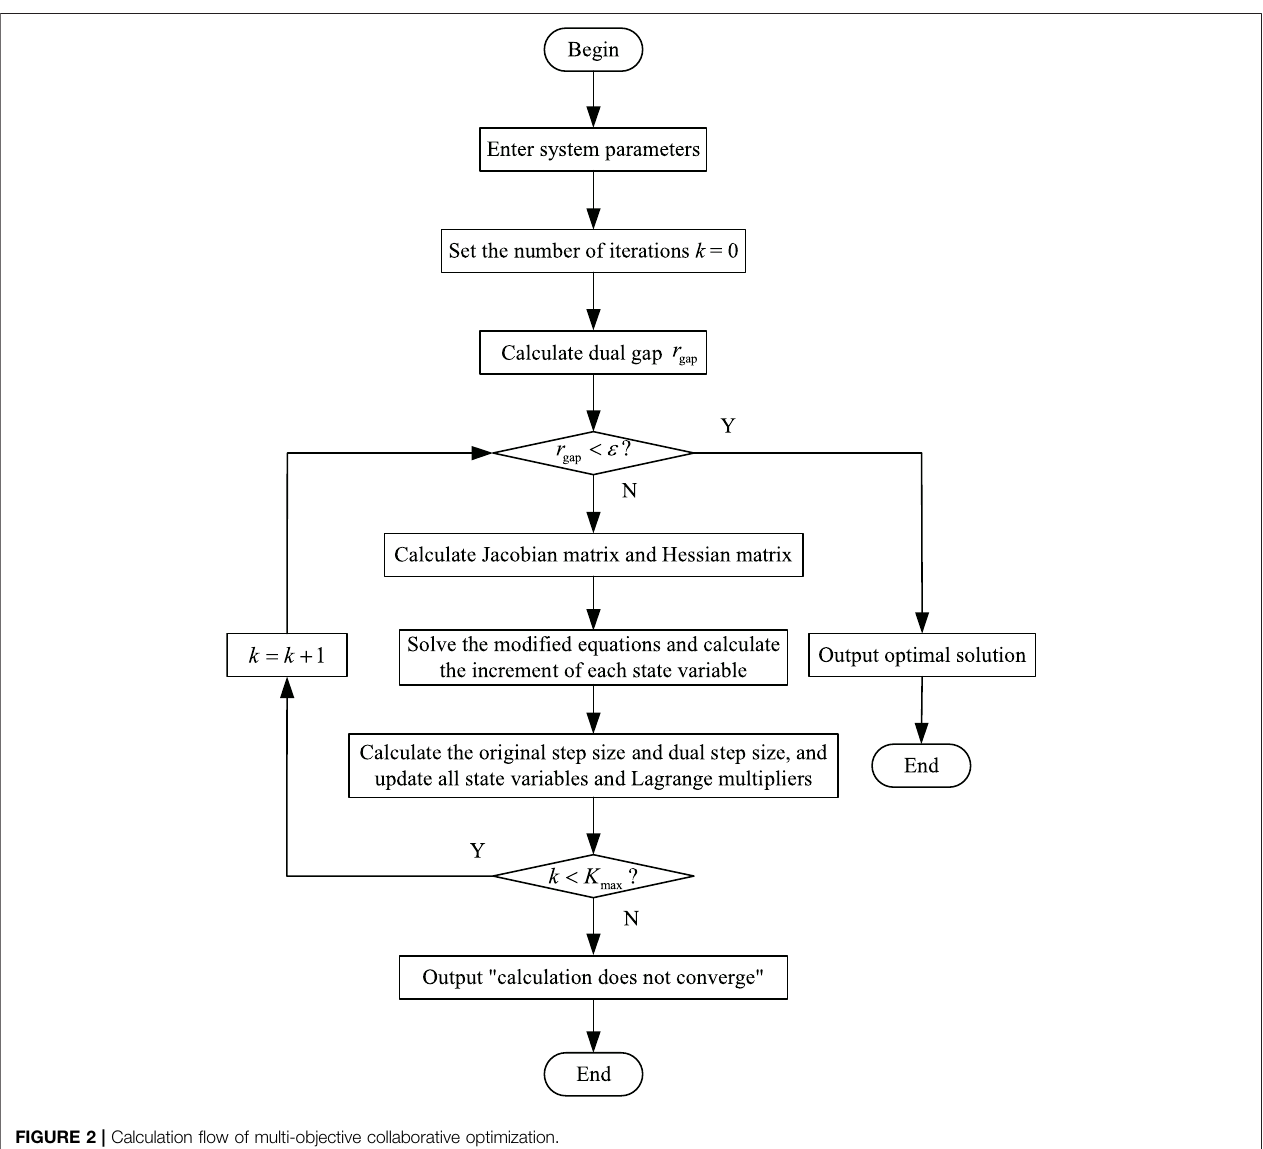
FIGURE 2 | Calculation fl ow of multi-objective collaborative